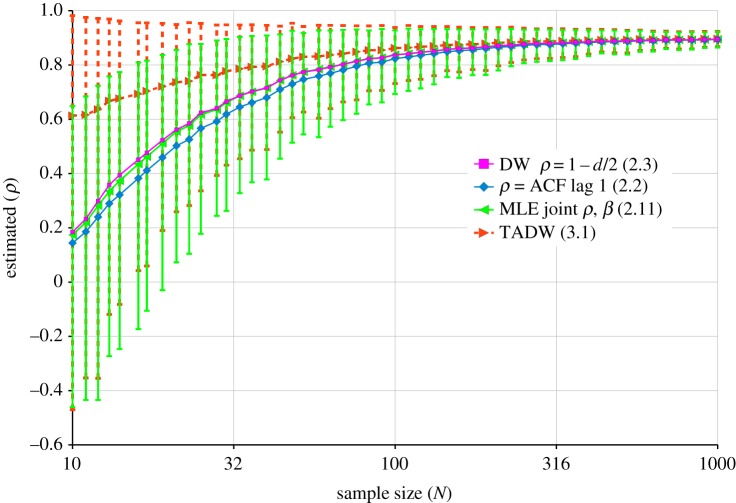
Estimated ρ-values for 1000 trials with AR(ρ = 0.9) noise, at each sample size, N. The blue curve is the estimate from the OLS residual ACF; the magenta curve is from the Durbin–Watson statistic of the OLS residuals, using ρ = 1 − d/2. The light-green curve, with 95% confidence interval error bars, uses the iterative joint maximum-likelihood (ML) estimate of (2.7). The ML curve is surprisingly close to the Durbin–Watson curve. The red dashed curve, with dotted 95% confidence interval error bars, uses the new tanh adjusted Durbin–Watson estimate of (3.1). This figure shows the performance with one model variable, but similar results are obtained with more variables, though with slightly more bias at low N.